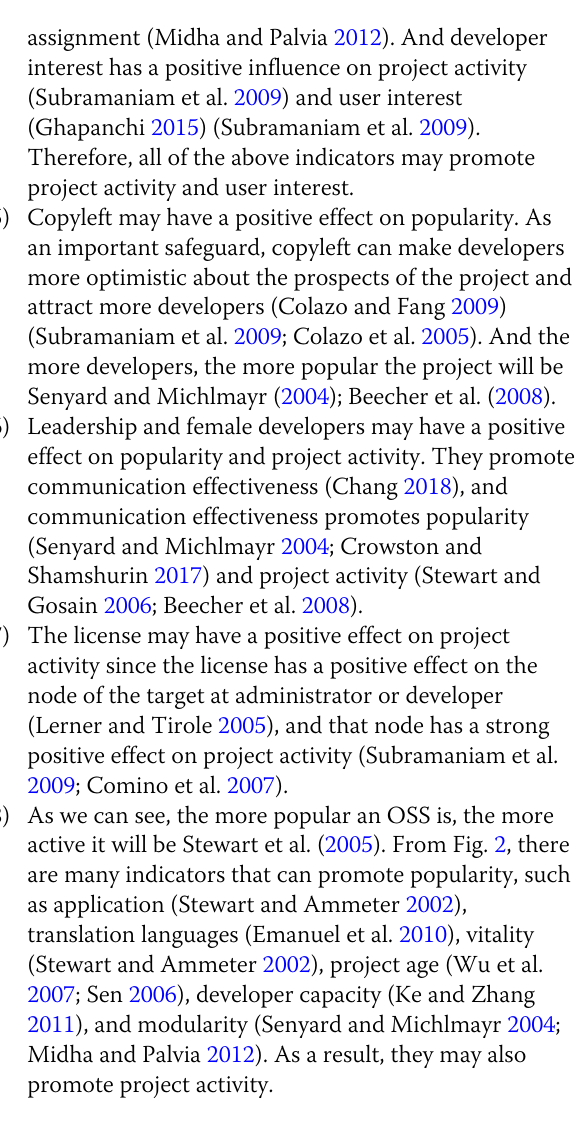
+ −→ B ” means A makes a positive impact on B ,